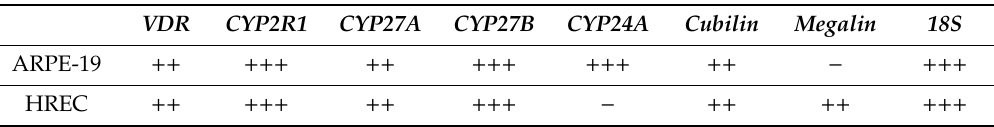
Table 1. Summary of the main vitamin D (VITD) synthesizing genes in human retinal pigment epithelial cells (ARPE-19) and human retinal endothelial cells